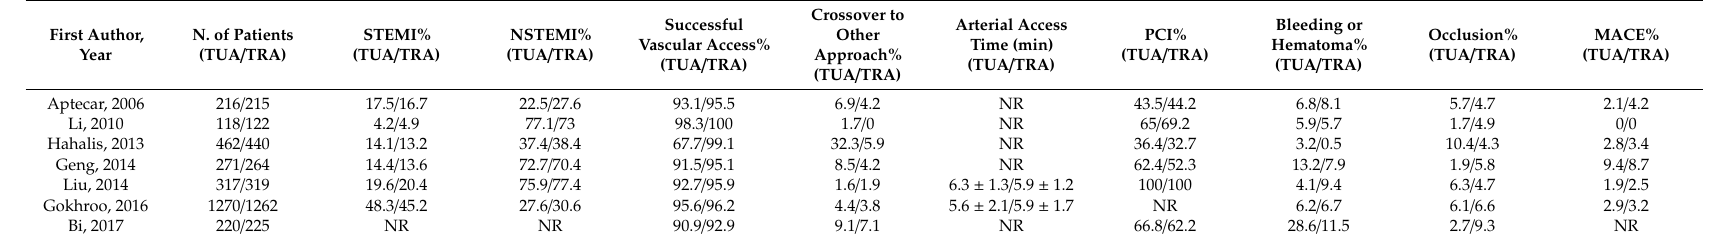
Table 2. Clinical studies of transradial vs. transulnar